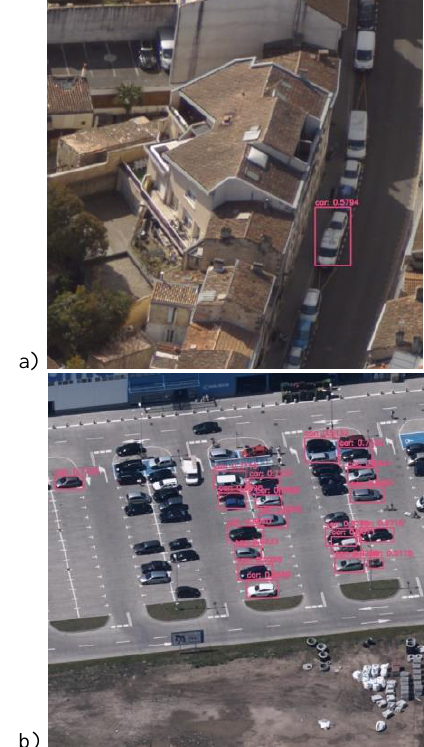
Figure 2 Results of the first experiment - object detection with the YOLO algorithm learned on MSCOCO images: a) Bordeaux, b) Elbląg.